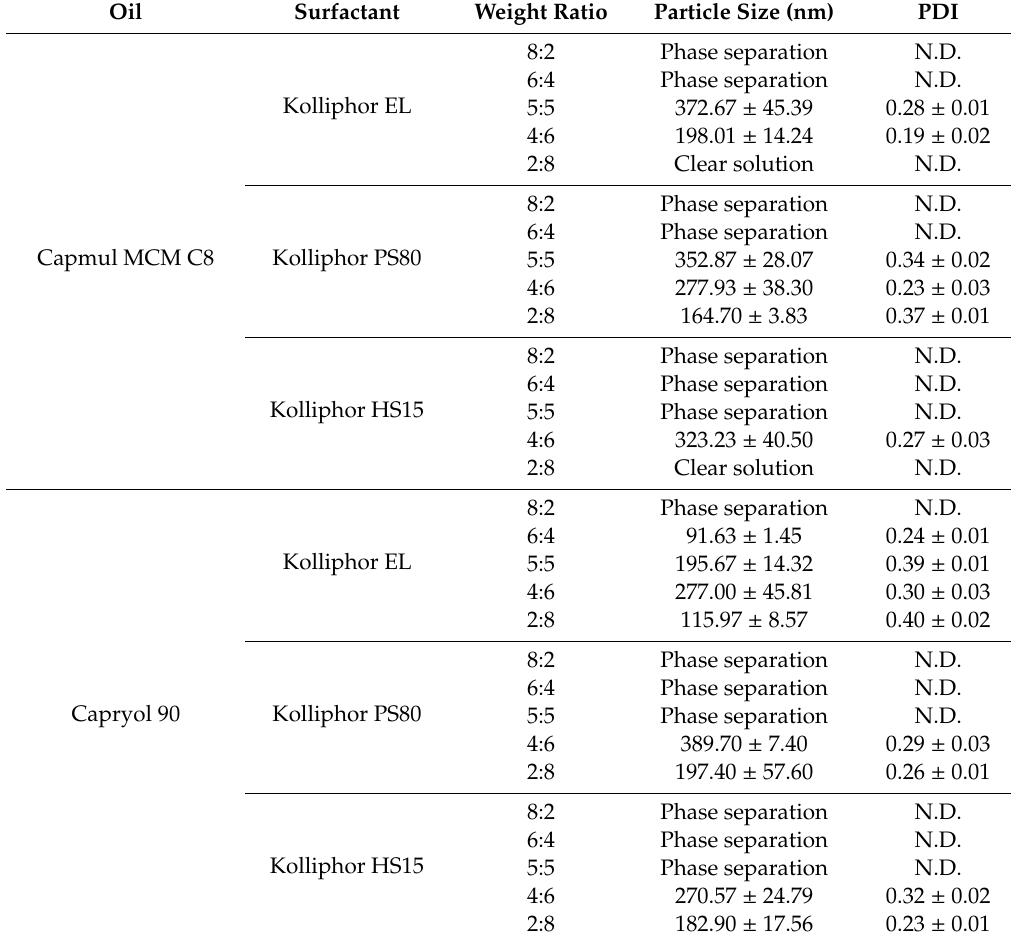
Table 1. Particle size and dispersibility of the vehicle in